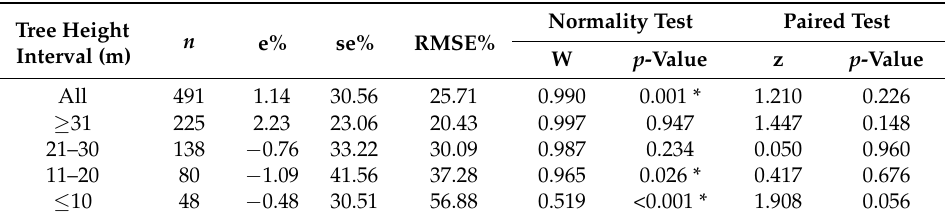
Table 6. Differences between the measured and derived tree diameters.